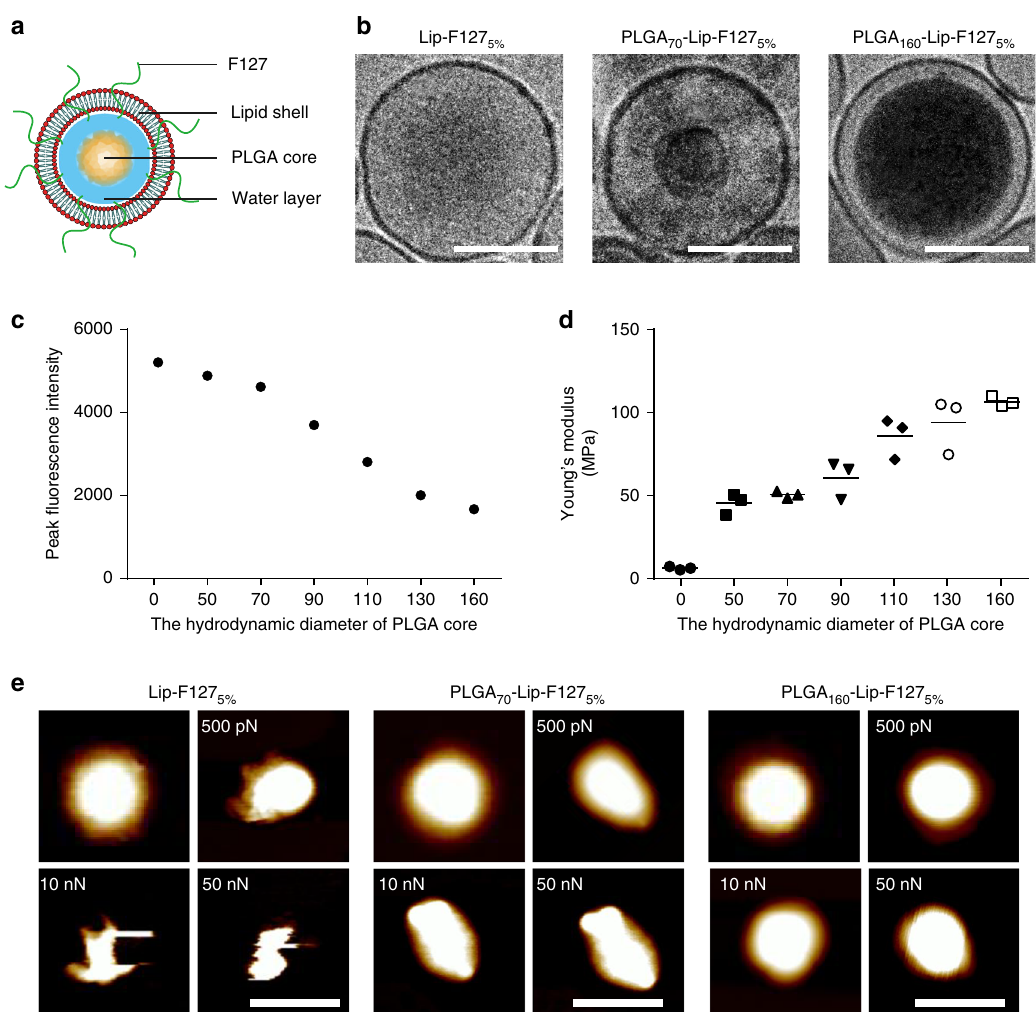
Fig. 1 NP characterization. a A schematic diagram of a core-shell PLGA-lipid NP. b Cryo-TEM images of a Lip-F127 5% NP (left), a PLGA 70 -Lip-F127 5% NP (middle), and a PLGA 160 -Lip-F127 5% NP (right). Scale bar: 100 nm. c Peak fl uorescence intensity and d Young ’ s modulus values of NPs with different hydrodynamic diameters of PLGA core. ( n = 3). e Atomic force microscopy (AFM) images of Lip-F127 5% NPs, PLGA 70 -Lip-F127 5% NPs, and PLGA 160 -Lip- F127 5% NPs and the corresponding deformation images of the NPs after being subjected to forces of different magnitudes. Scale bar: 200